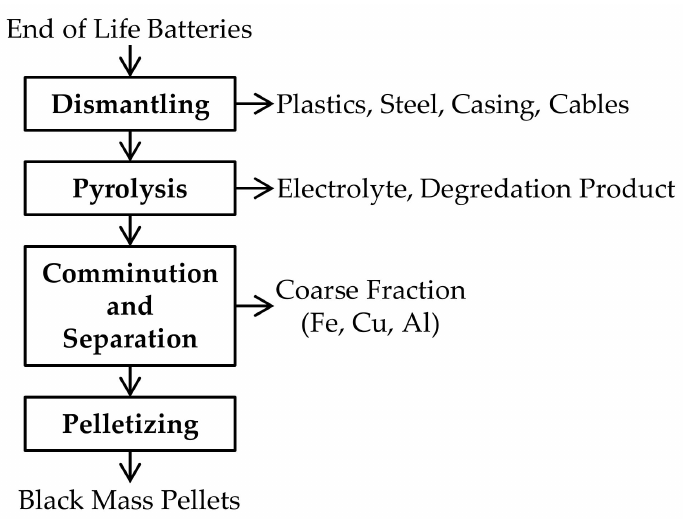
Figure 1. Schematic process flow sheet for black mass pellet generation.